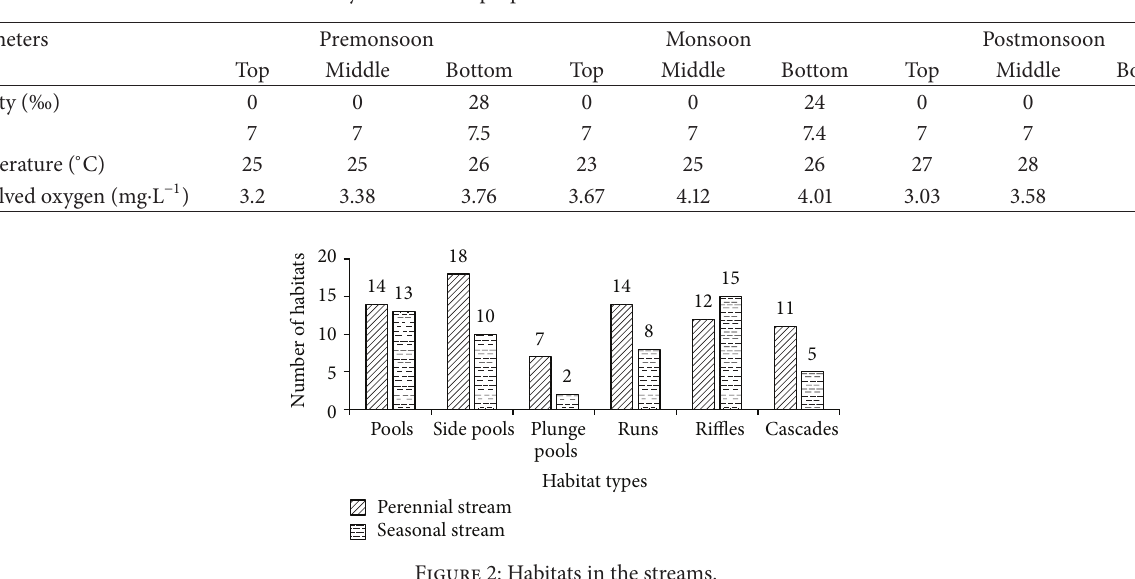
Table 3: Physicochemical properties of the water in the seasonal stream.